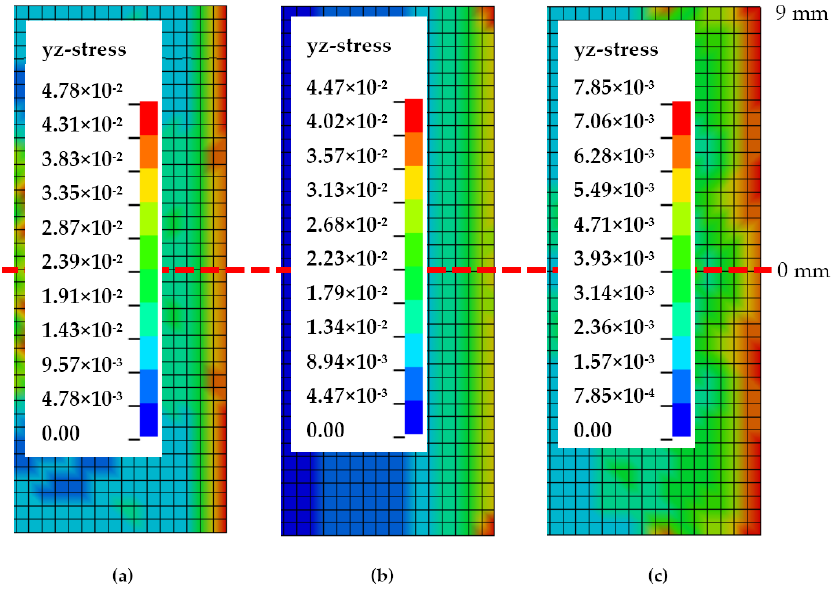
Figure 9. Mode-II crack front stress distribution at ( a ) 30, ( b ) 70 and ( c ) 110 °C.